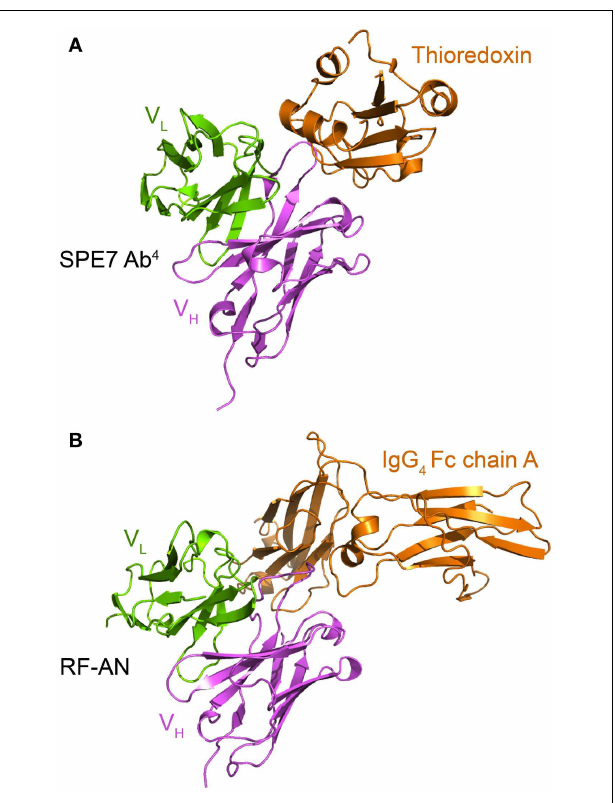
FIGURE 6 | Both the cytokinergic IgE SPE-7 and the autoantibody RF-AN use similar protein surfaces to mediate cross-reactive protein-protein interactions. (A) Crystal structure of SPE-7 IgE bound to a phage display selected mutant thioredoxin (pdb: 1OAZ).The major SPE-7 IgE conformer (Ab 1 ) binds to the thioredoxin to form the Ab 4 -thioredoxin complex (James et al., 2003). (B) Crystal structure of the IgM autoantibody RF-AN bound to the IgG 4 Fc domain (pdb: 1ADQ; Corper et al., 1997). For clarity only the proteins within the asymmetric unit of the crystal and the Fv region of RF-AN are